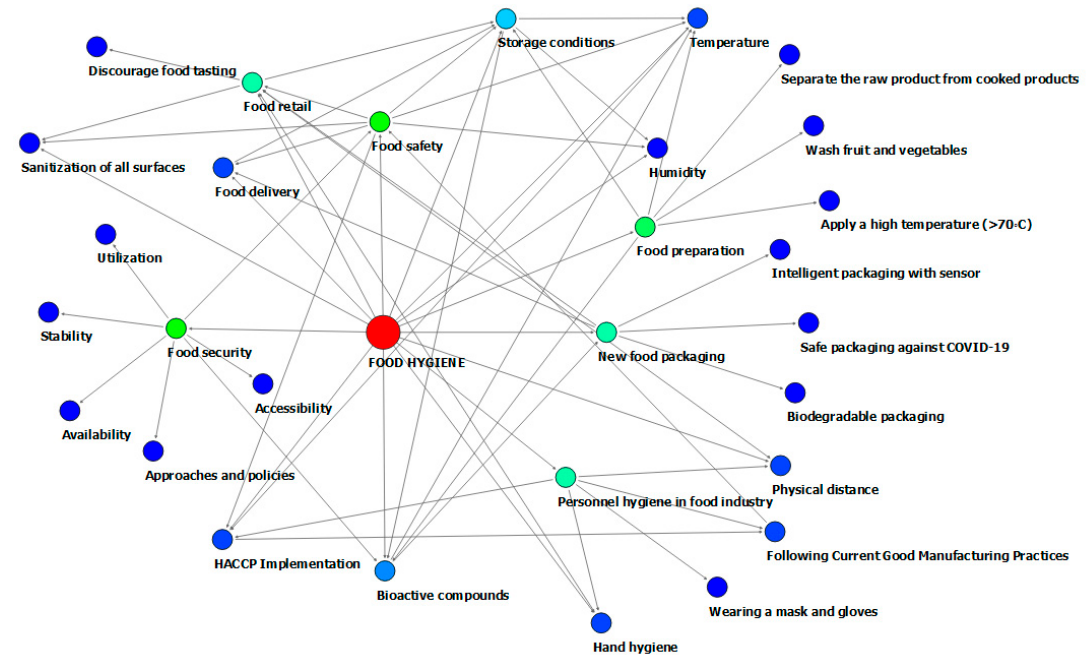
Figure 3. Network connections to food hygiene in food supply systems .